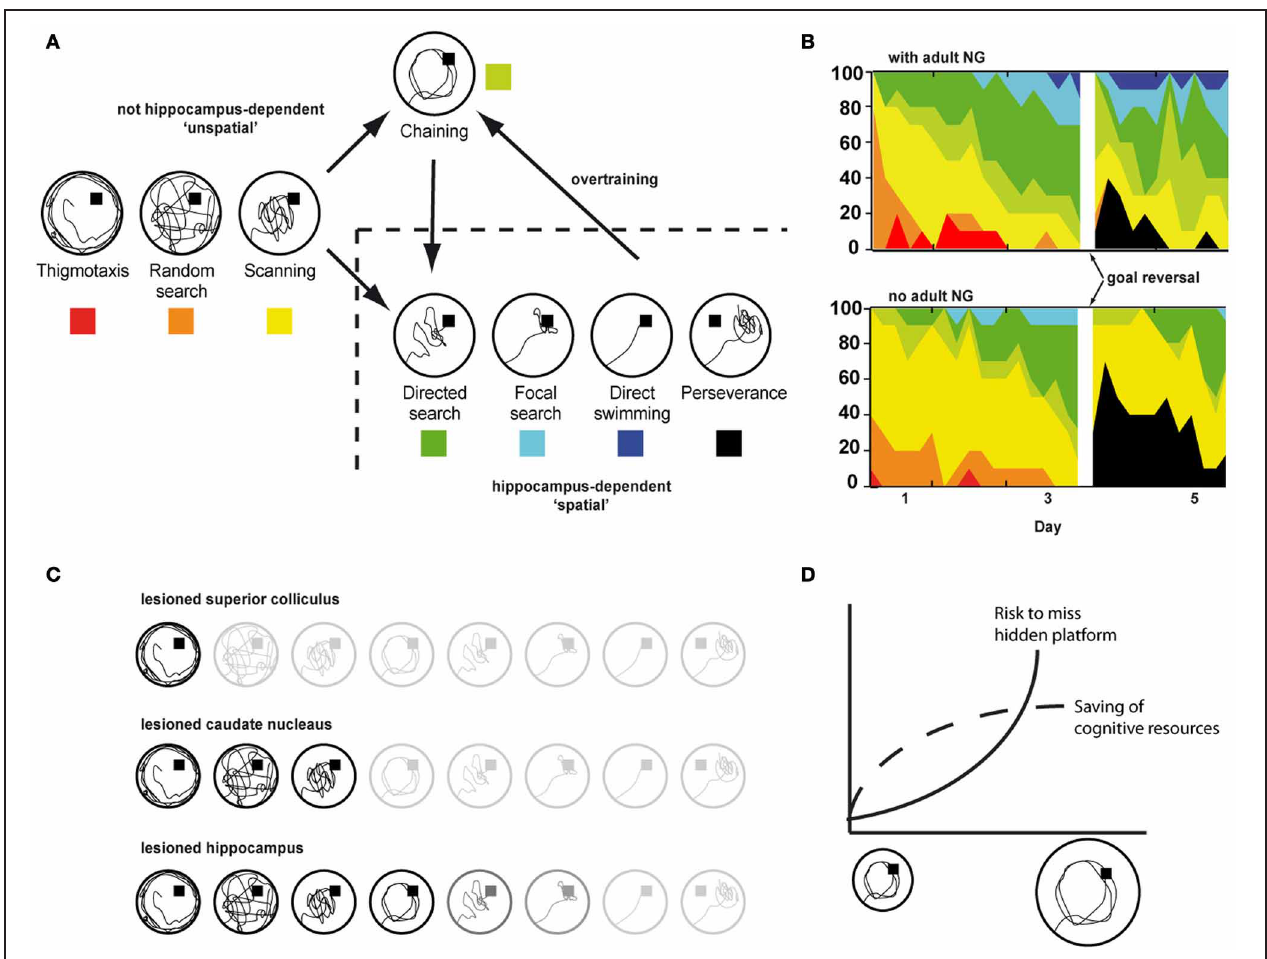
(C) Effects of selective lesions to different brain structures on search strategies in the water maze. Blurred items represent strategies not shown following the indicated lesion. (D) Chaining as an instantiation of the least-effort-principle in small but not in large water maze